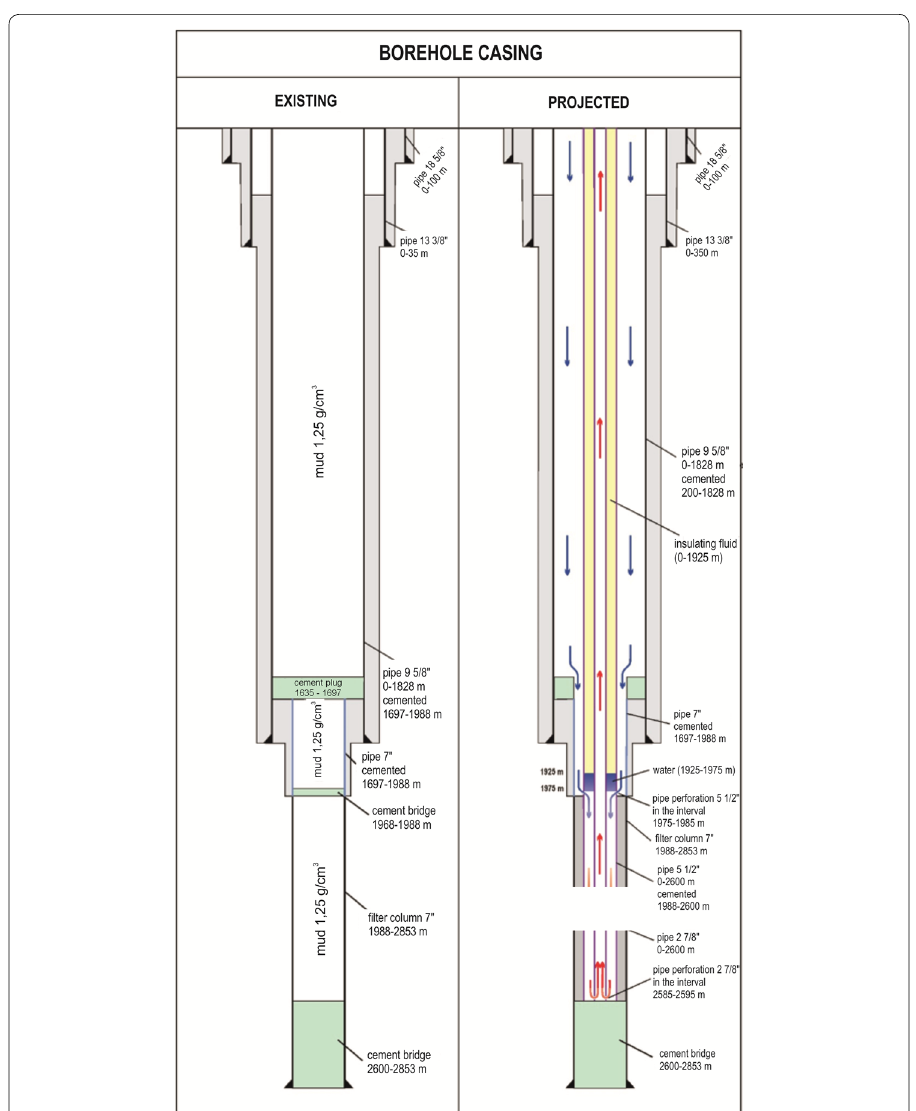
Fig. 15 Schematic design of the downhole coaxial heat exchanger in the Czarny Potok GT-1 well (Bujakowski et al.